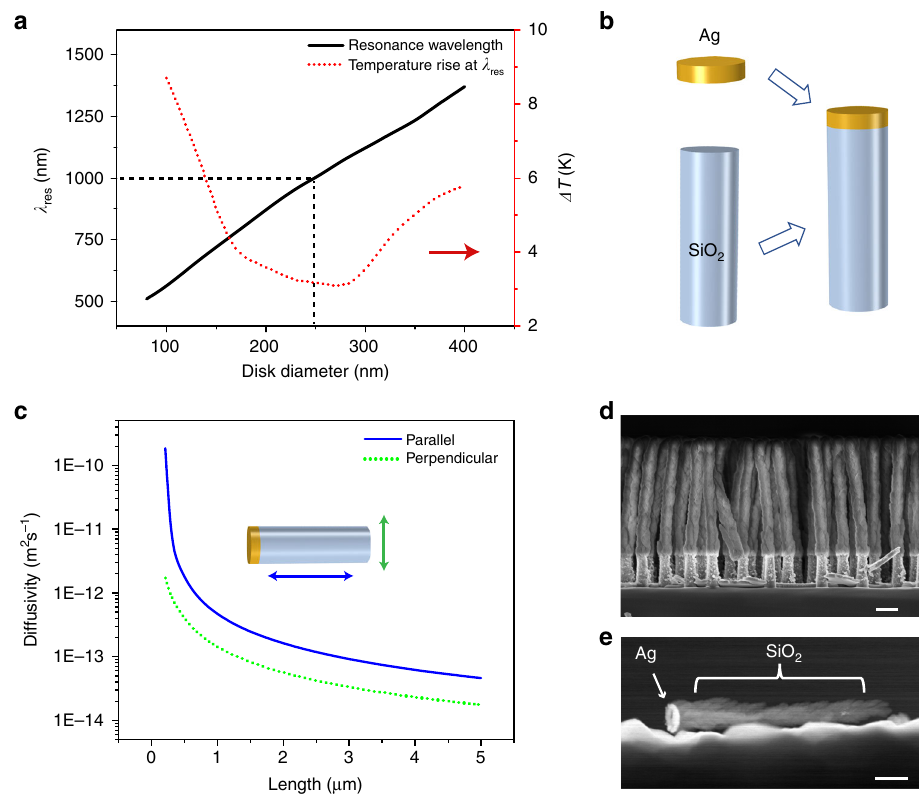
Fig. 2 Active colloidal tweezers. a Resonance wavelength and temperature rise of the nanodisk immersed in water plotted as a function of disk diameter. b Design of an ACT formed by integration of the plasmonic nanodisk with a dielectric nanorod. c Brownian diffusivities 55 of nanorods as a function of length, along parallel and perpendicular directions to the long axis. d Scanning electron microscope (SEM) image of an array of ACTs on the substrate. Scale bar is 500 nm. e Transmission electron microscope (TEM) image of the single ACT released from the substrate. Scale bar is 300